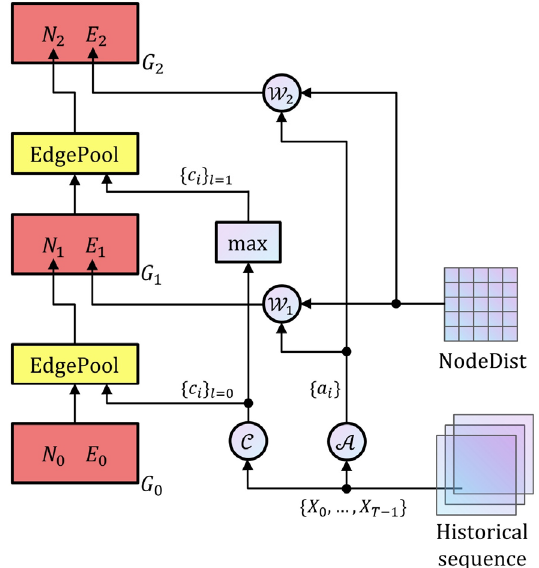
Figure 3. Hierarchical graph generation process generates high-level graphs G l ( l > 0) from initial graph G 0 , historical sequence, and geographic distance between nodes